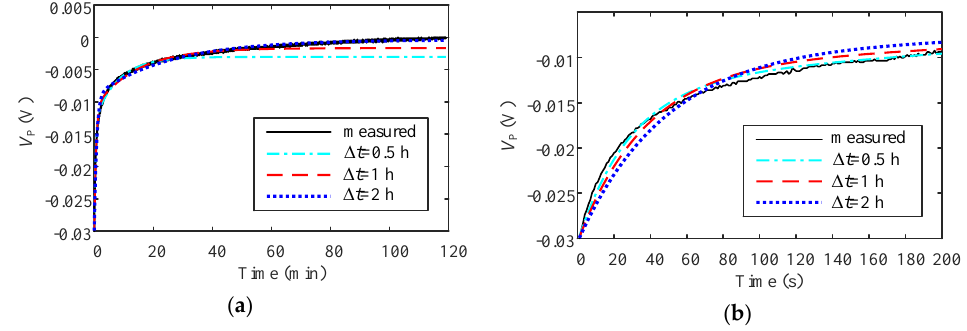
Figure 9. Curve fitting results of V P during the rest period of the discharging pulse-rest test at 60% SoC : ( a ) the overall result; ( b ) a close look at the transient part at the beginning.